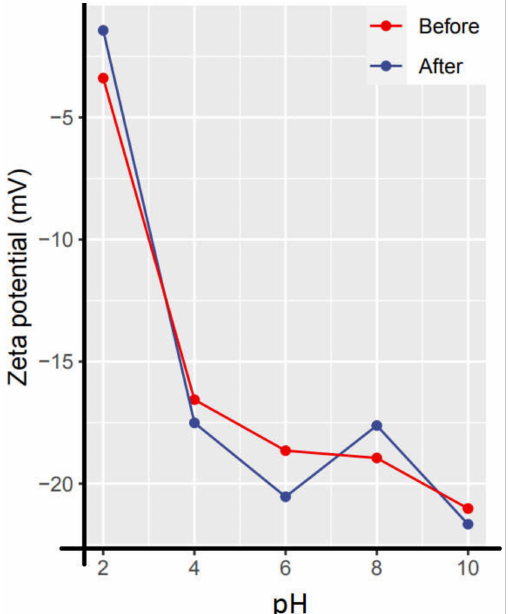
Figure 15. Zeta potential of the obtained AuNPs at different pH values. The different pH values were adjusted before and after the preparation of